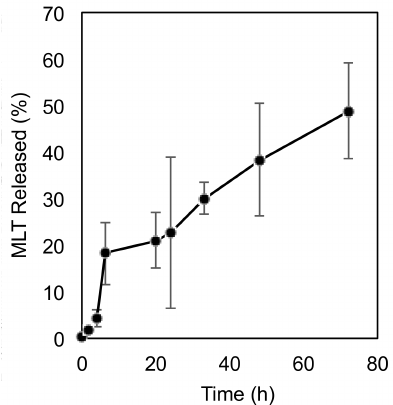
Figure 5. Release of small molecule MLT from PEG-P(MLT) by chymotrypsin cleavage. Data shown as the mean ± S.D. ( n = 3).